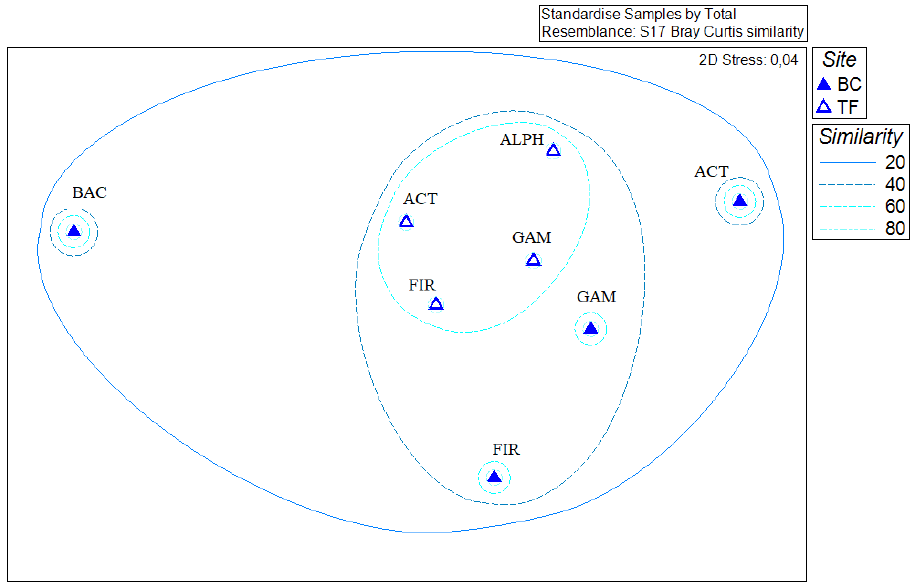
Figure 6. Non-metrical multidimensional scaling (nMDS) analysis (Bray-Curtis similarity matrix) computed on the entire phenotypic data set, evidencing connections with the phylogenetic affiliation of isolates.